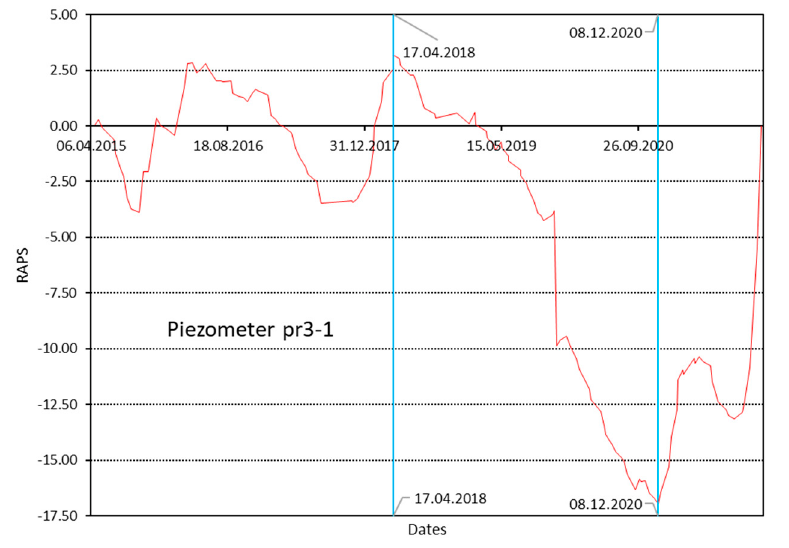
Figure 13. RAPS values for piezometer PR3/1.